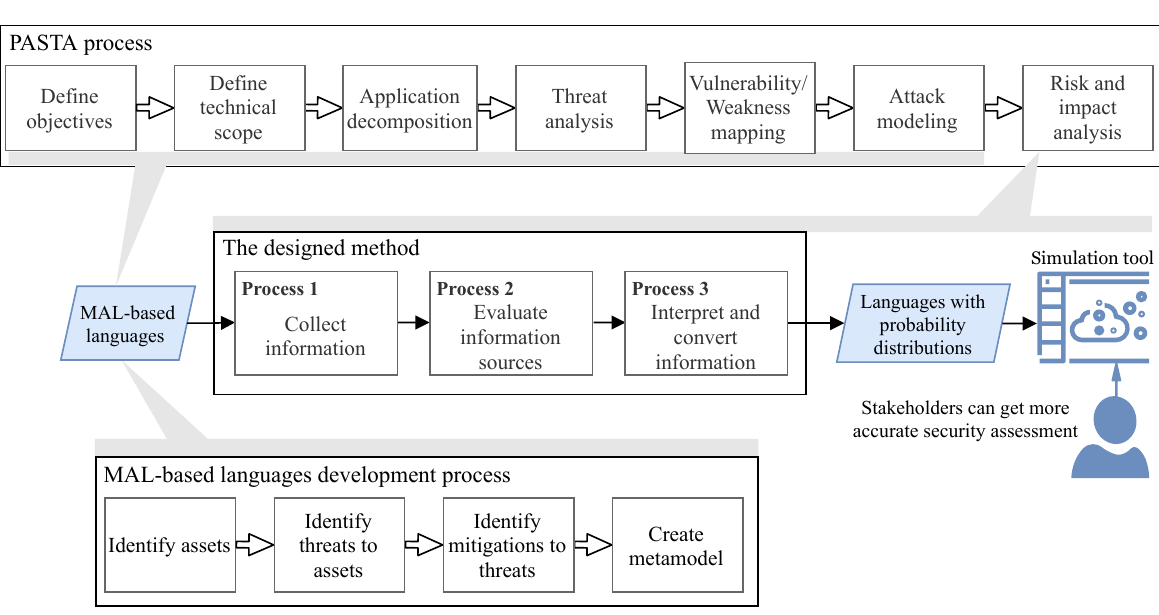
Figure 4. Overview process for attack simulation and threat (PASTA)